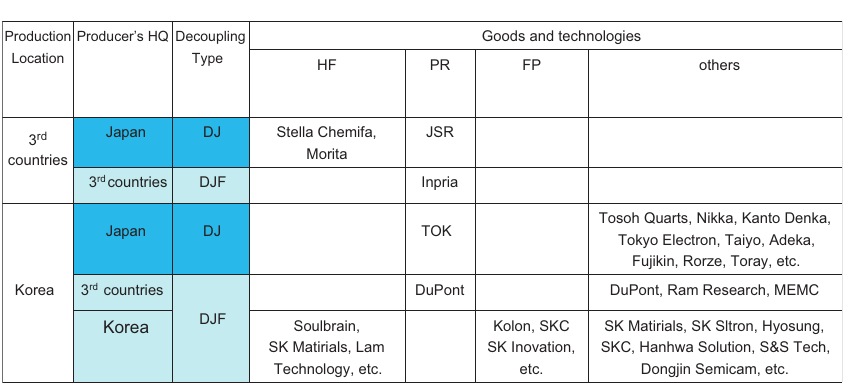
Table 1. CurrentstateofKorea ’